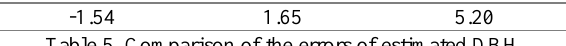
Table 5. Comparison of the errors of estimated DBH